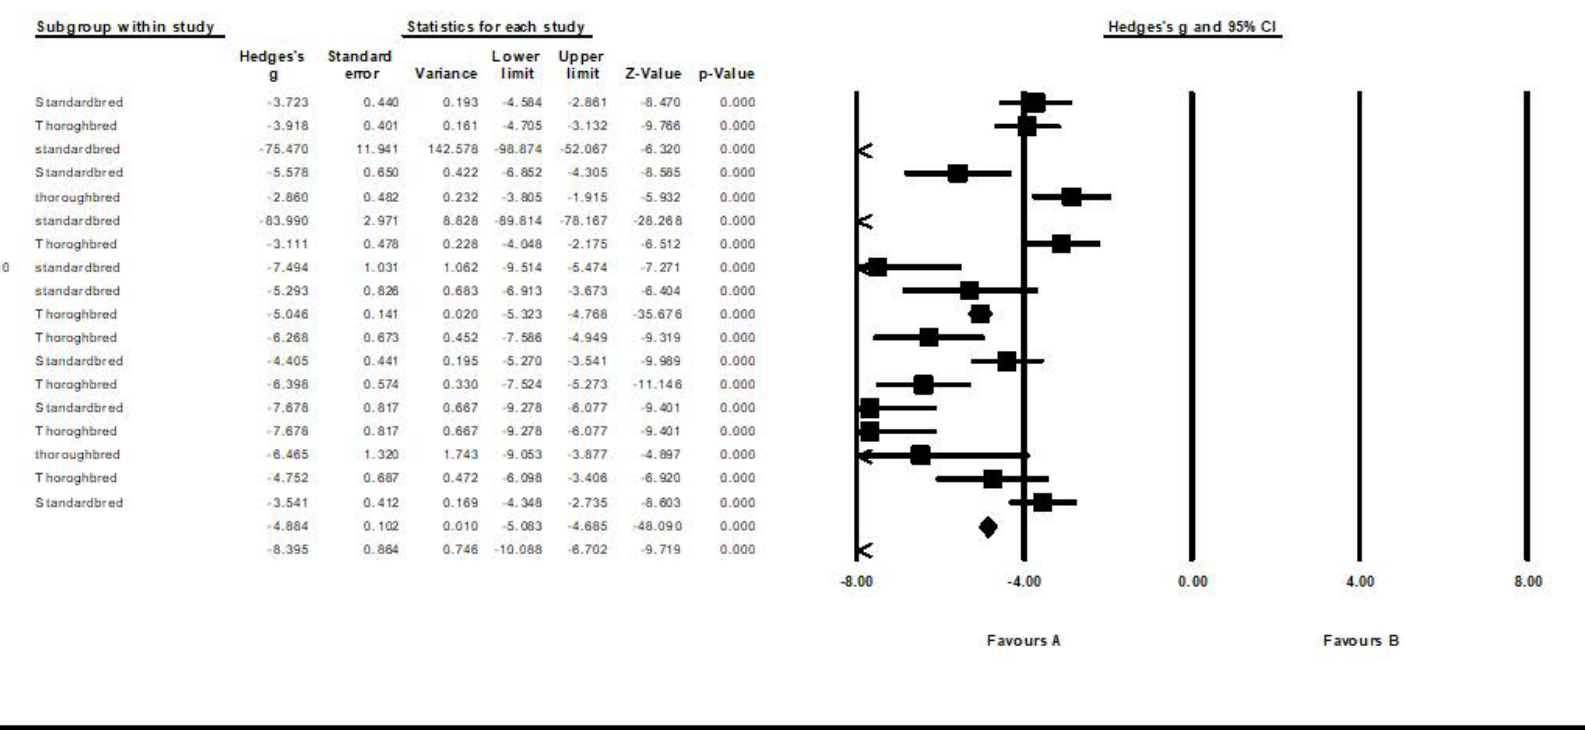
Figure 3. Forest plot for left ventricular internal diameter (LVID) measurements in Thoroughbred and Standardbred horses. Studies and their respective citations: Al-Haidar et al., 2013 [35]; Al-Haidar et al., 2010 [2]; Bakos et al., 2002 [21]; Brown et al., 2003 [22]; Buhl et al., 2005 [18]; Collins et al., 2010 [36]; Grenacher and Schwarzwald, 2010 [37]; Kriz et al., 2000 [38]; Leadon et al., 1991 [23]; Long et al., 1992 [39]; Michima et al., 2004 [8]; Patteson et al.,1995 [6]; Pipers and Hamlin, 1977 [7]; Slater and Herrtage, 1995 [20]; Zucca et al., 2008